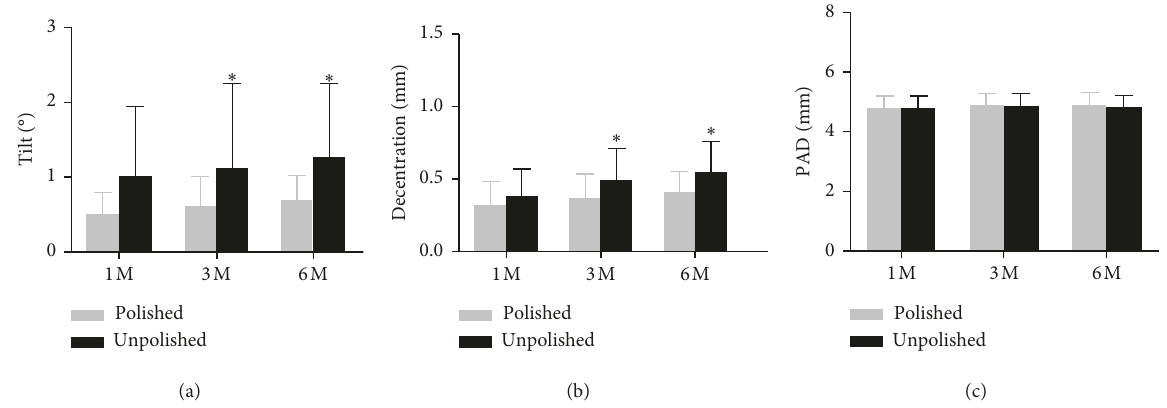
Figure 2: The differences in IOL stability between the two groups ( ∗ Significant at p < 0 . 05).